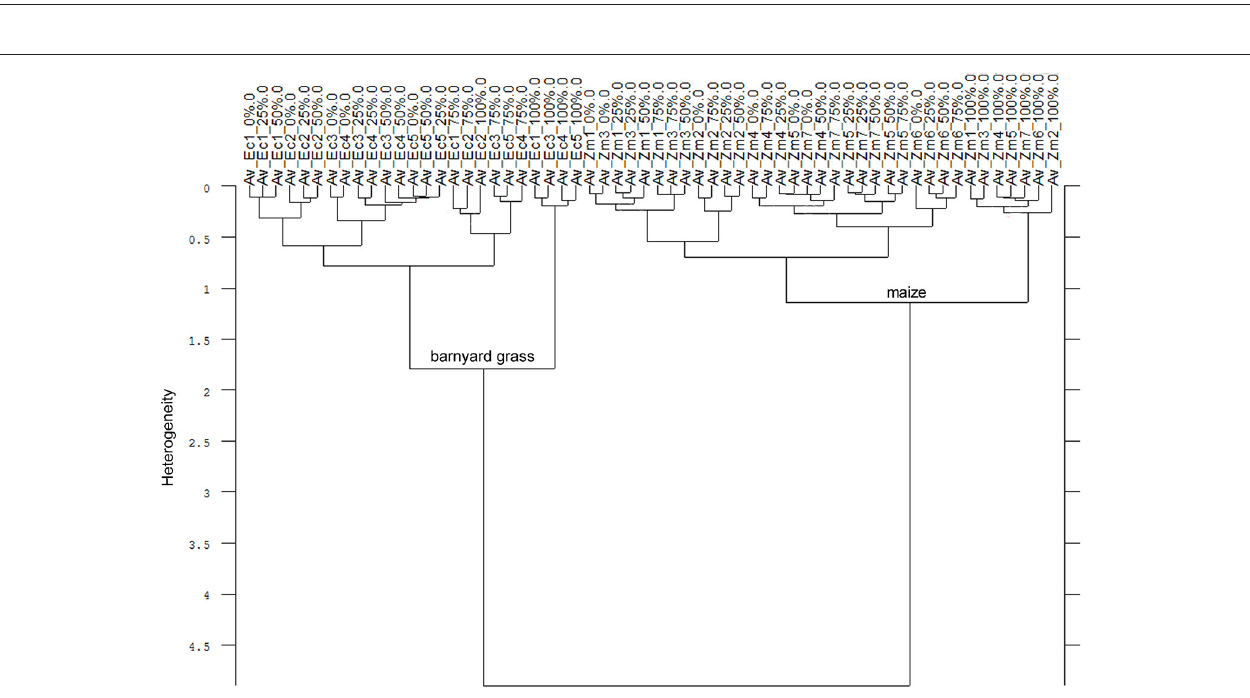
FIGURE 6 | Cluster analysis of the Av-spectra of all cultivars of the species Zea mays (Zm, maize) and all proveniences of the species Echinochloa crus-galli (Ec, barnyard grass) for the united experiment 2 (exp. 2-1 and 2-2). Cluster analysis was evaluated with the first derivation and vector normalization of the reduced frequency range (3,751–2,749 cm − 1 and 1,801–599 cm − 1 ), Ward’s algorithm and Euclidian distance. The Av-spectra are averages (Av) of FTIR-ATR spectra of the different root segments (100% root tip, 0% root basis etc.; see Figure 1 for scheme, Table 2 for n, Table 1 for names of cultivars and proveniences).